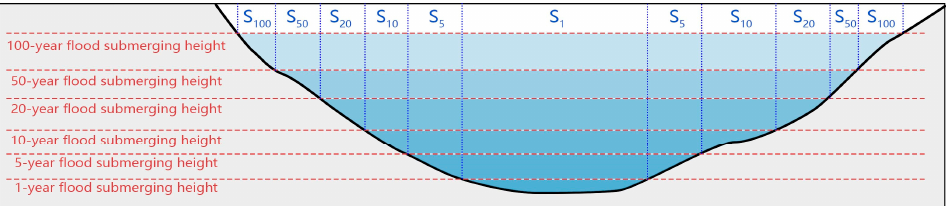
Figure 6. Calculation of catchment capacity within the simulated flood-submerged areas.